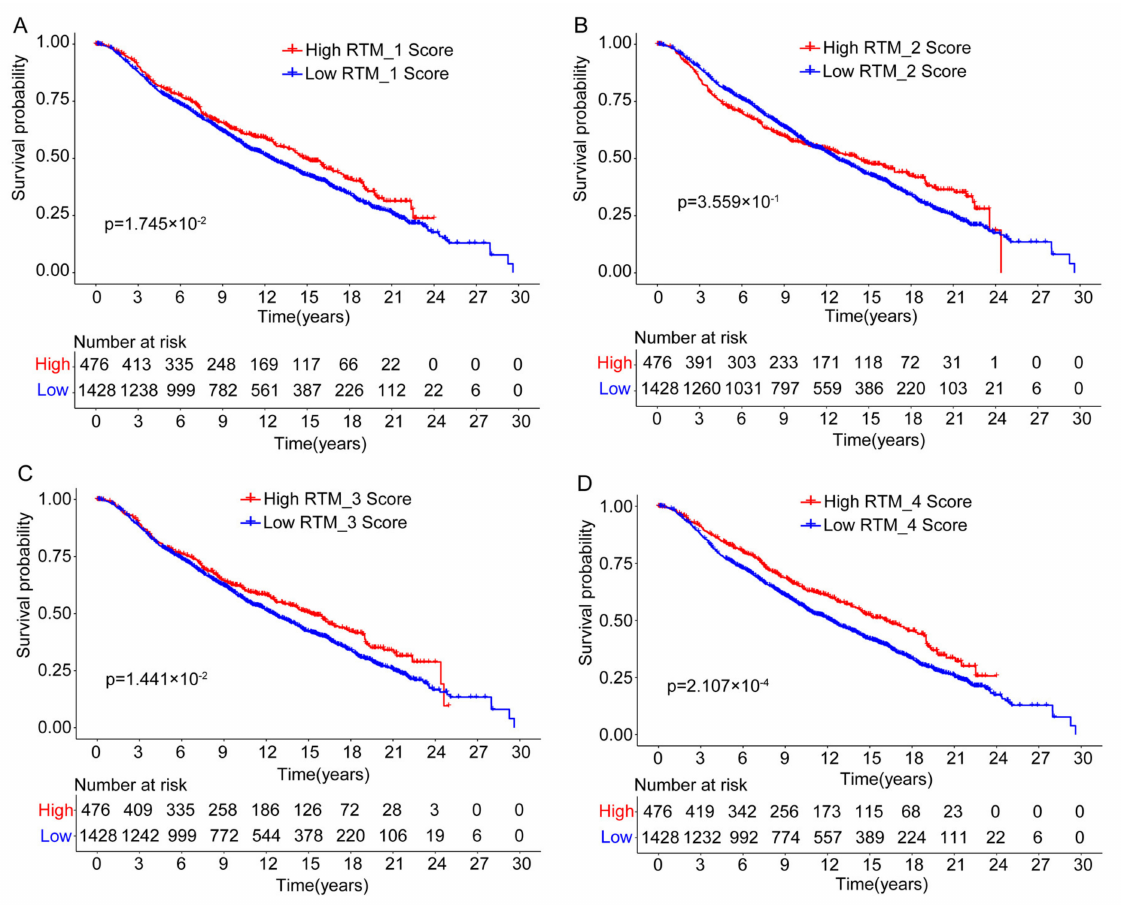
Figure 4. The prognostic association between RTM clusters and overall survival. ( A – D ) Kaplan-Meier survival analysis showed that all RTM clusters, excluding RTM_2 ( B ), were significantly correlated with improved overall survival in breast cancer patients. Split patients by upper